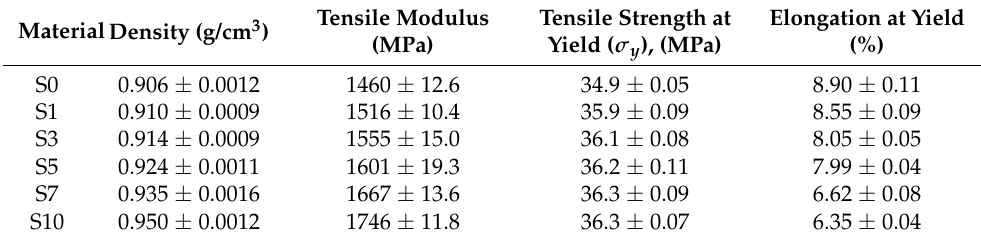
Table 6. Density and mechanical properties of PP/microsilica